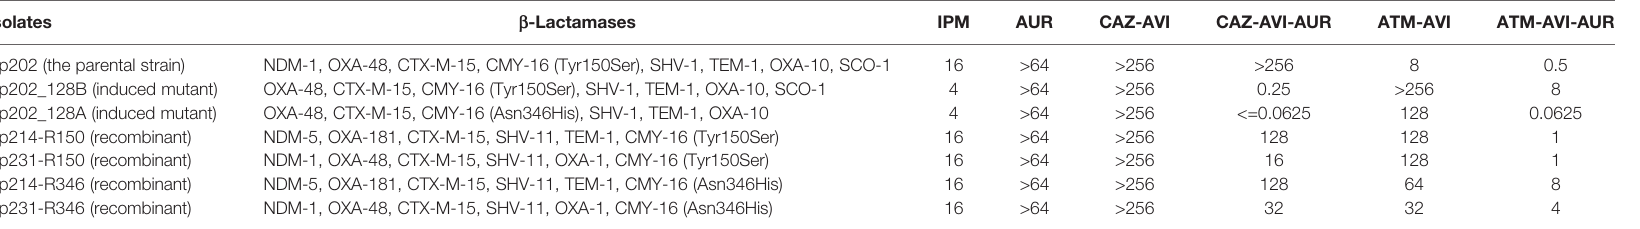
TABLE 2 | Activities of ATM-AVI-AUR against ATM-AVI resistant K. pneumoniae isolates mutants and transformants ( m g/mL). Isolates b -Lactamases Kp202 (the parental